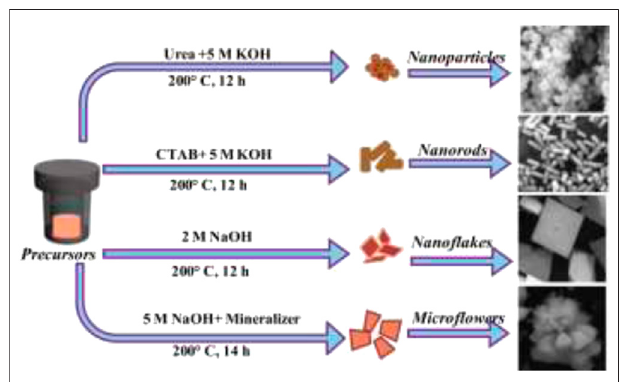
FIGURE 2 | Schematic illustration for tuning the morphology BFO nanostructures with different experimental conditions by the hydrothermal process (Remya et al.,